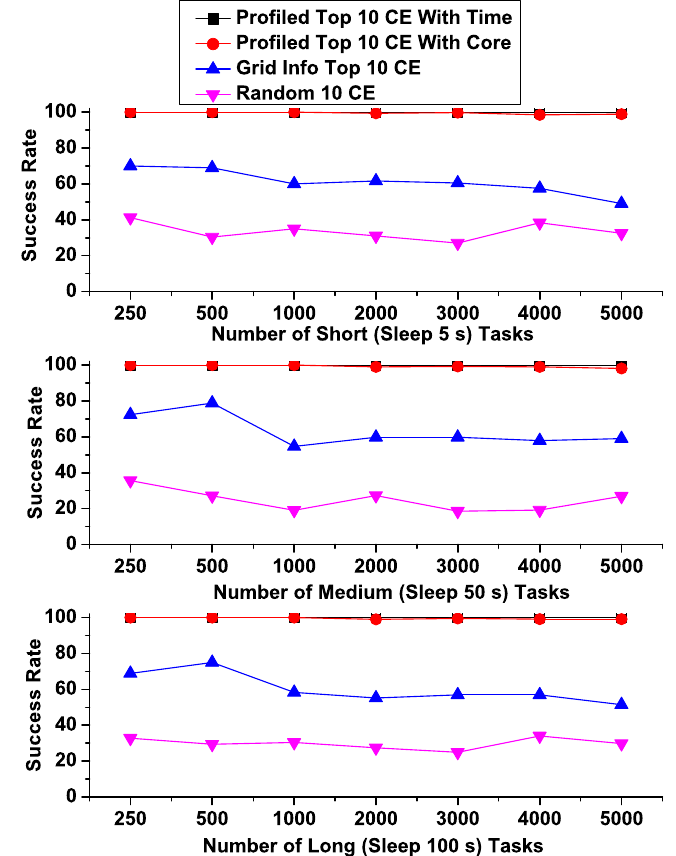
Figure 10. Success Rates of Short, Medium and Long running